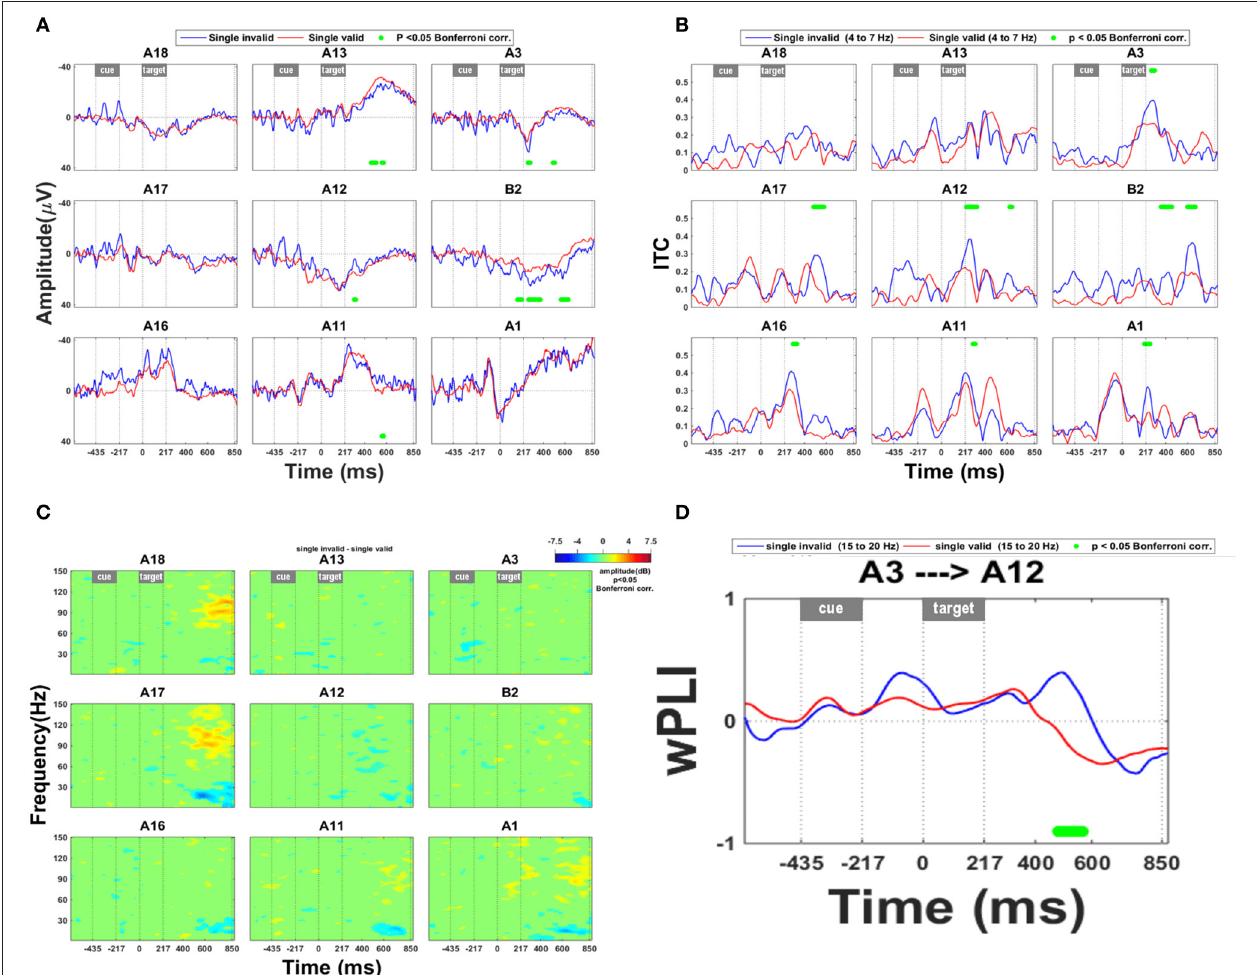
FIGURE 3 | Invalidity effect. (A) ERP during validly cued trials and during invalidly cued trials. Significant deficits following target onset between validly cued and invalidly cued trials are marked by a green bar. The significance threshold is set at P < 0.05 corrected for the number of electrodes during a minimum continuous period of 10 ms. The plots for the different electrodes are positioned in accordance with their position on the cortical surface. (B) ITC analysis within the theta band (4–7 Hz) during invalid vs. valid cueing trials. The significance threshold is set at P < 0.05 corrected for the number of electrodes ( n = 9) using a nonparametric bootstrapping approach with 1000 randomizations. (C) Time-frequency plots during invalidly minus validly cued single-grating trials. The ERSP is thresholded at P < 0.05 corrected for the number of electrodes ( n = 9) using a nonparametric bootstrapping approach with 1,000 randomizations. (D) wPLI analysis for the frequency band from 15 to 20 Hz, indicating the effect of invalidity on functional connection between IPS and SPL. A positive y value means that the phase lead is in the direction from A3 to A12, as mentioned in the title of the plot, a negative y value that it goes in the opposite direction. The significance threshold was P < 0.05 corrected for the number of connections tested ( n = 36) using a nonparametric bootstrapping approach with 2,000